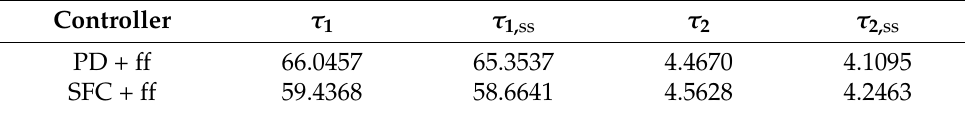
Table 9. RMS of applied torques comparative for the experimental implementation.